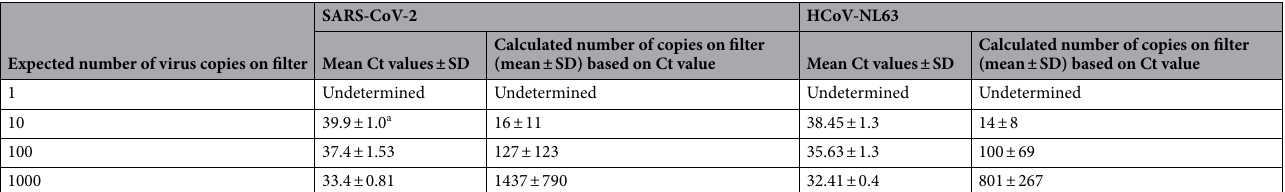
Table 1. Quantitative RT-PCR results of aerosolized SARS-CoV-2 and HCoV-NL63 filter extract samples and calculated virus copies on filters. a For this dilution, the positive results were obtained in four samples out of six.